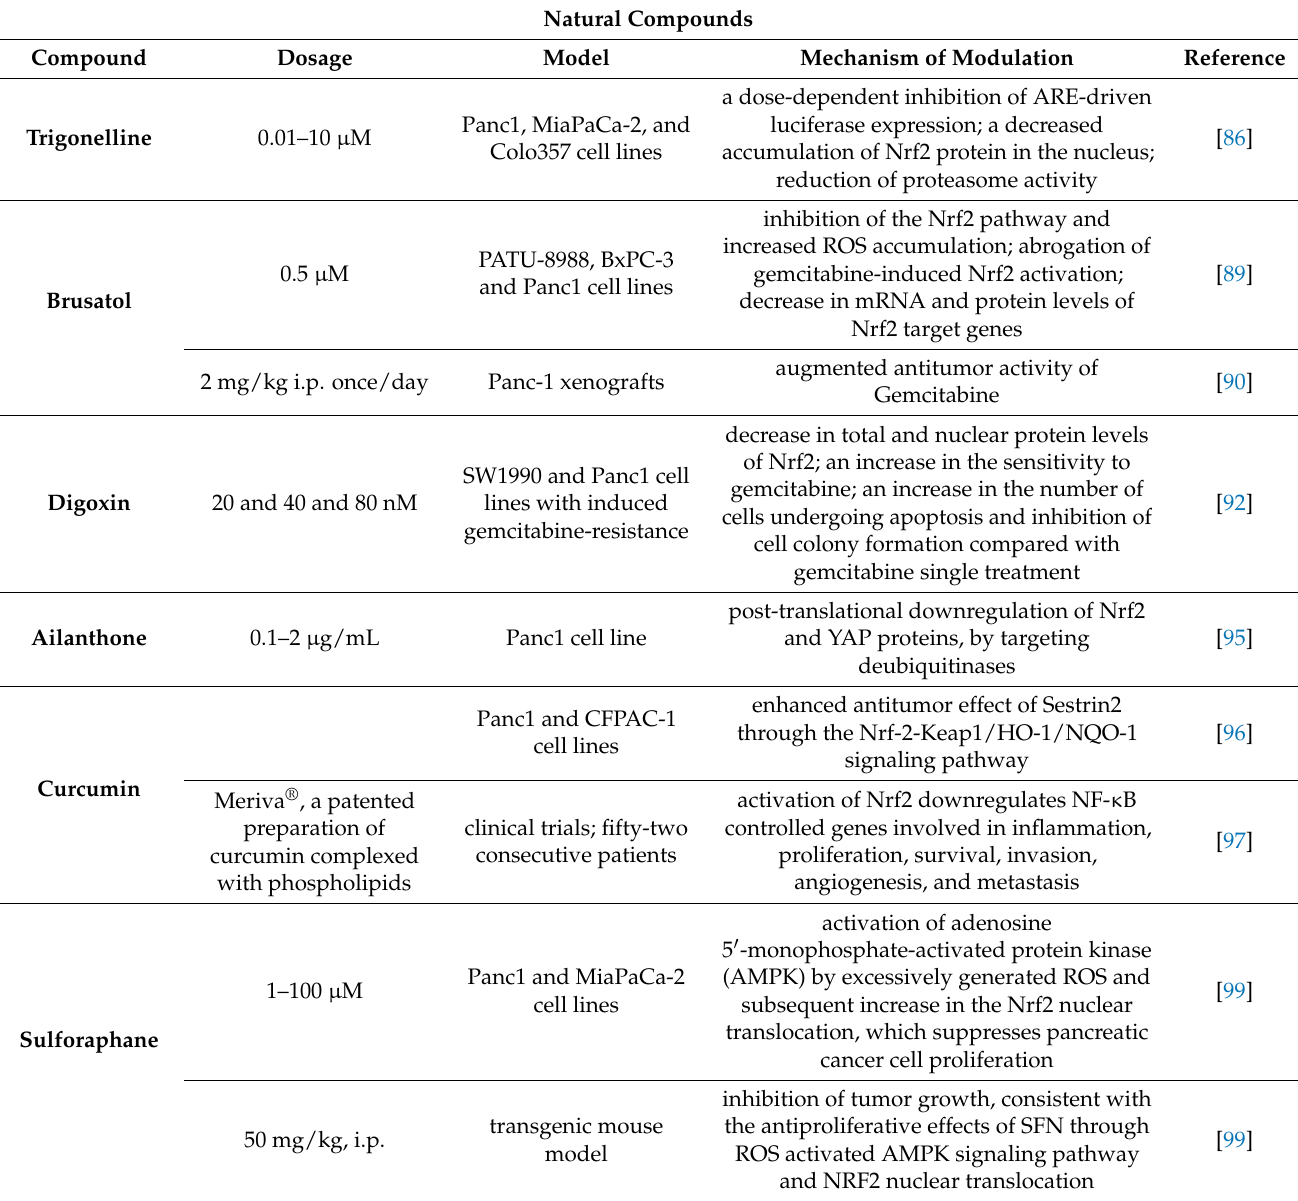
Table 1. Therapeutic strategies targeting Nrf2 in pancreatic